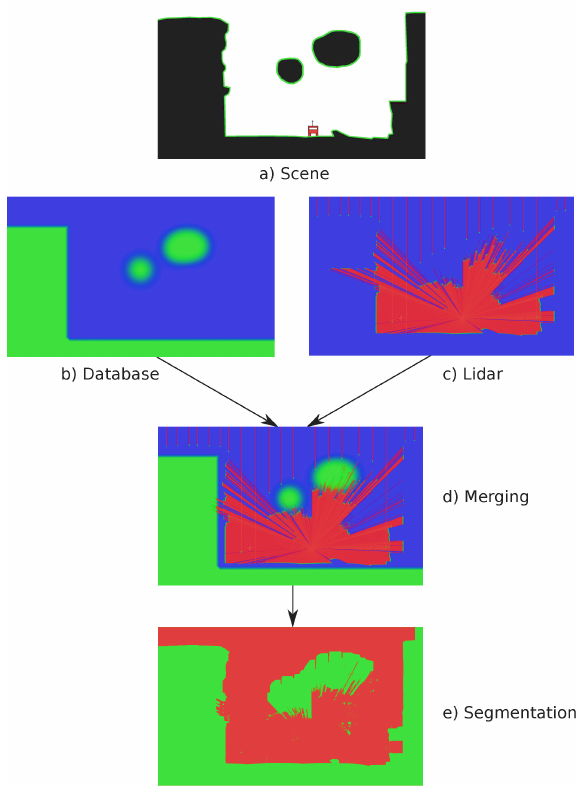
Figure 2: 2D example of the main scheme. The captured scene (a). The function related to the space occupancy : from a database (b), from ground and airborne laser information (c) (Red is out- side, green is inside). Merging of source (d). inside/outside seg- mentation (e).